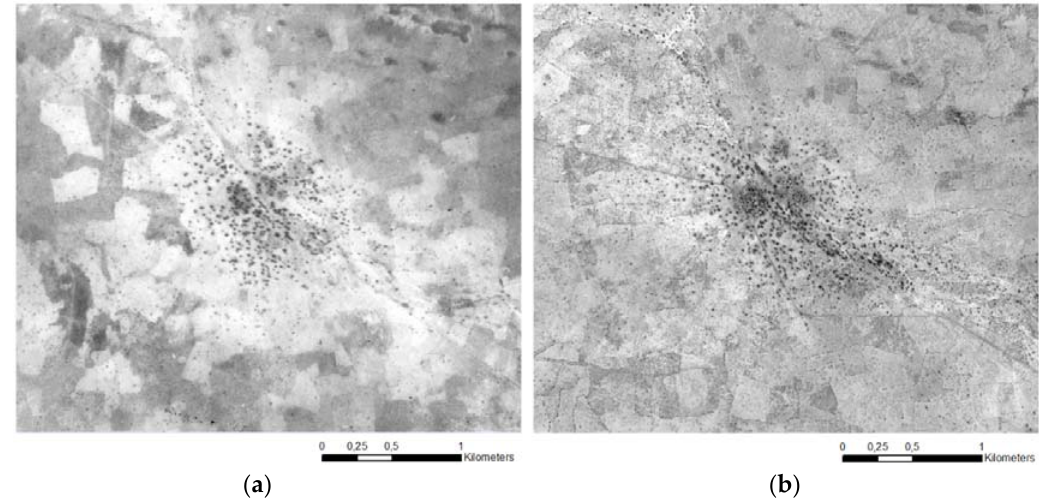
Figure 3. Original images of Guileyni utilized to test the method. ( a ) Image IGN, March 1975; ( b ) Image Digital Globe, January 2011.